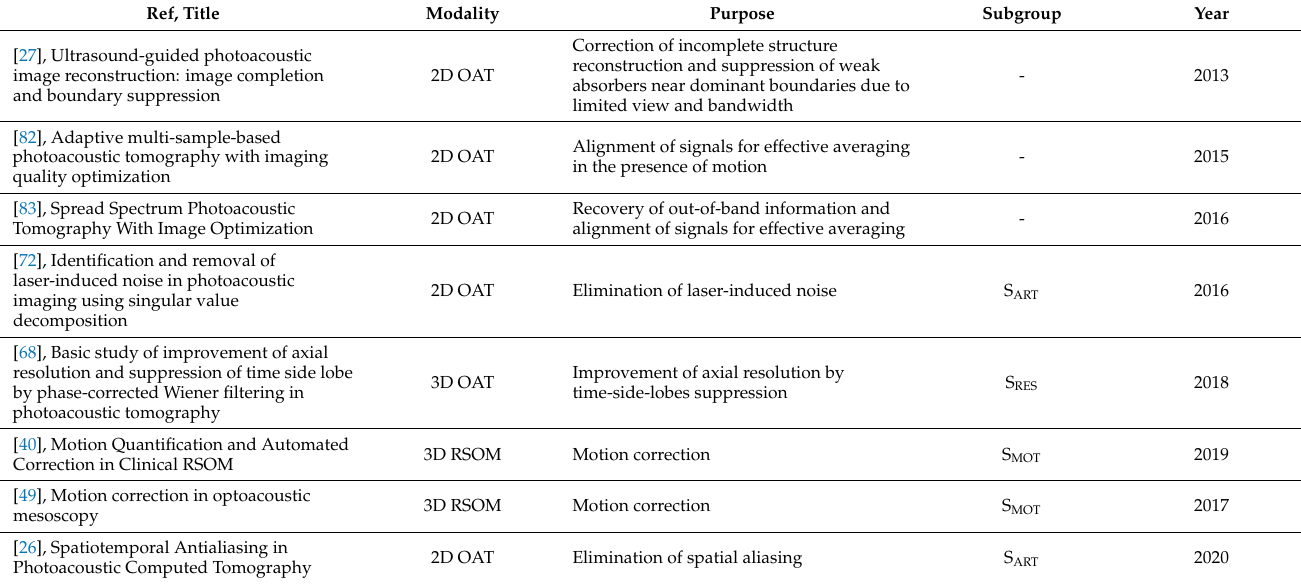
Table 4. Summary of the identified signal domain (pre-processing) approaches. OAT: optoa- coustic tomography, MSOT: multispectral optoacoustic tomography, RSOM: raster-scan optoacous- tic